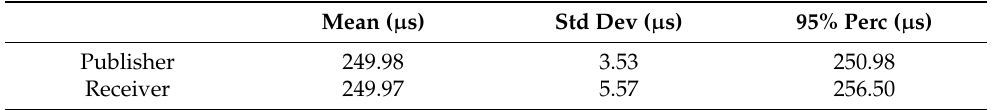
Figure 7. Cumulative distribution function of the transmission period as measured at the publisher and receiver side in red and blue, respectively. Shaded areas represent the resolution of Wireshark timestamp captures. Table 2. Transmission Period